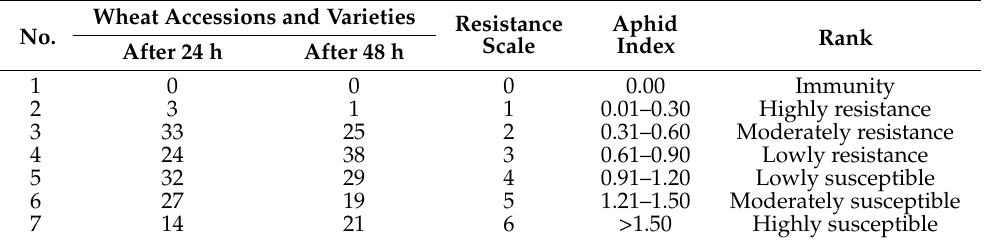
Table 1. Preliminary antixenosis resistance index for S. miscanthi on wheat accessions and varieties. Wheat Accessions and Varieties Resistance No.